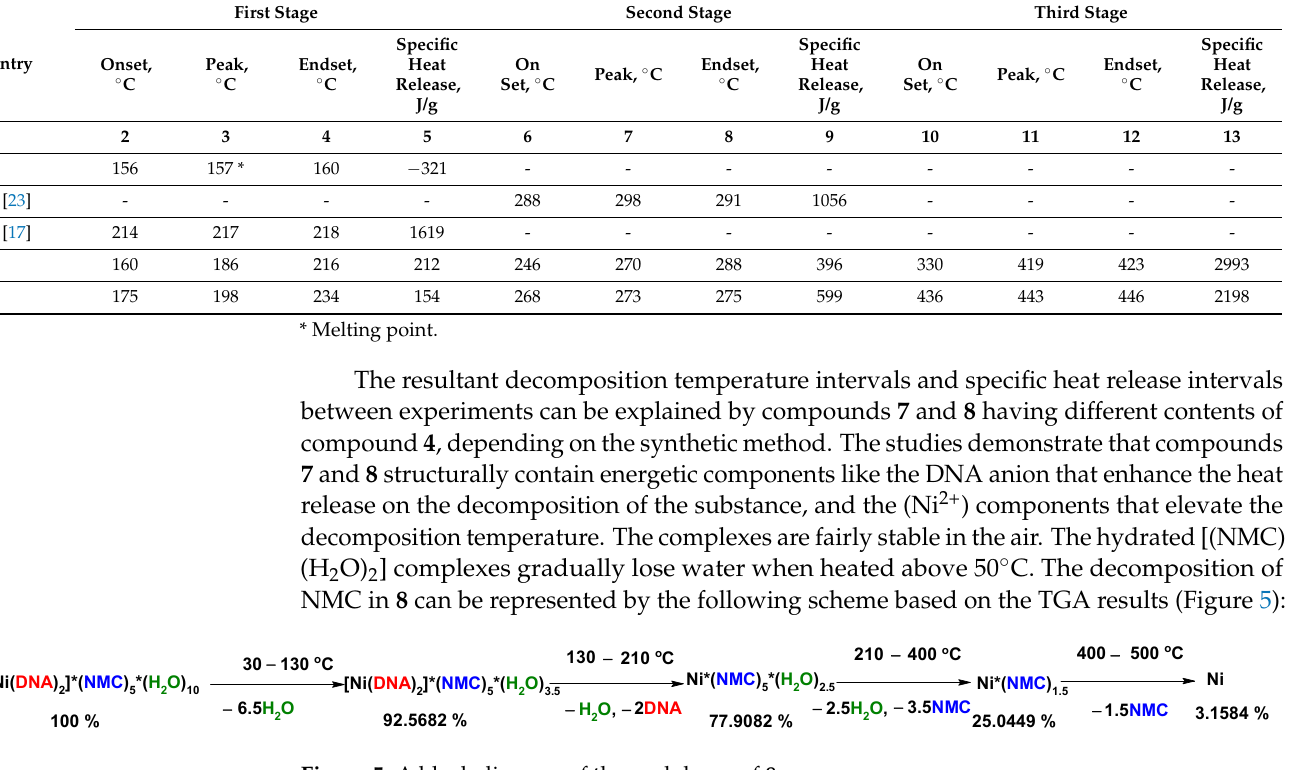
Figure 5. A block diagram of thermal decay of 8.